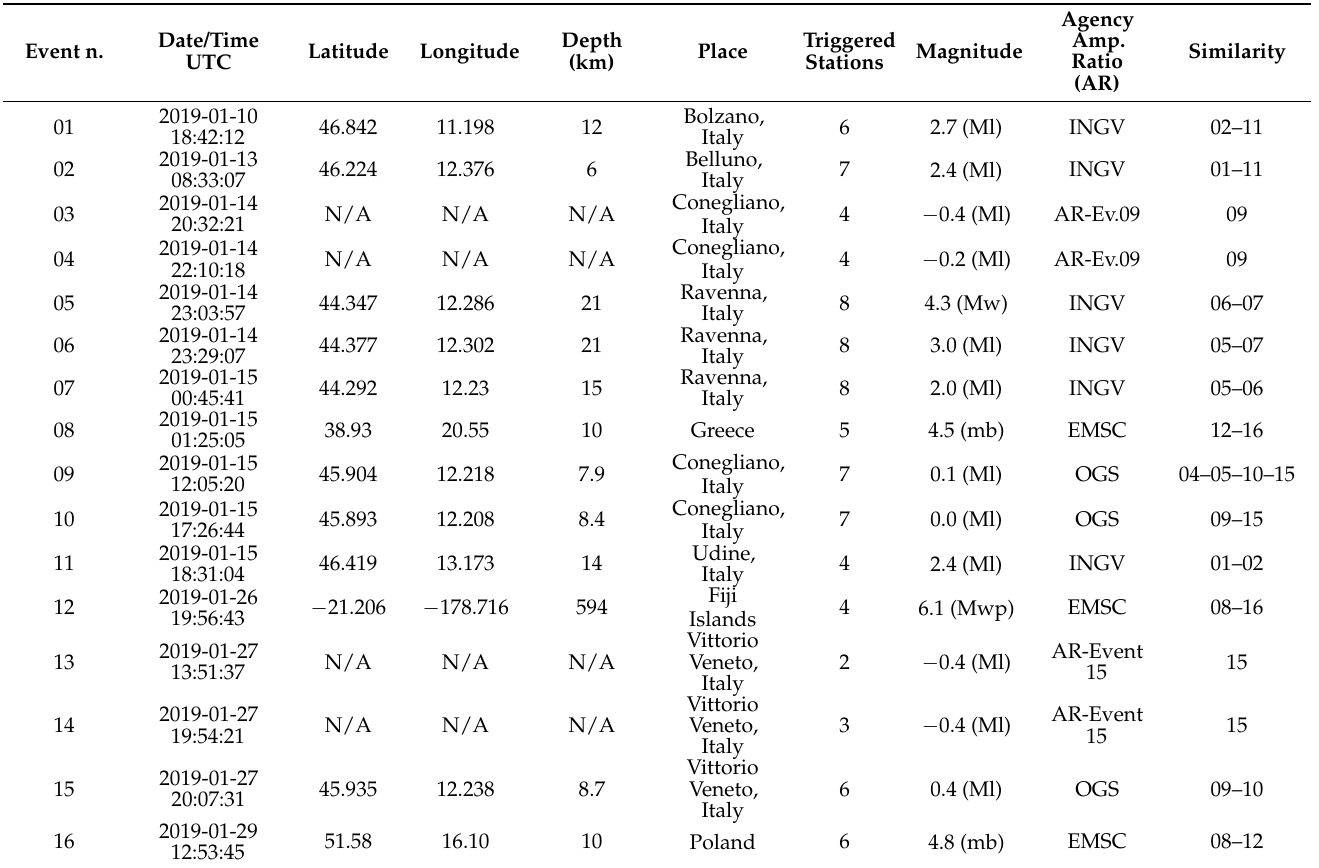
Table 1. Final catalog from the application of the FAST analysis to the array continuous data.